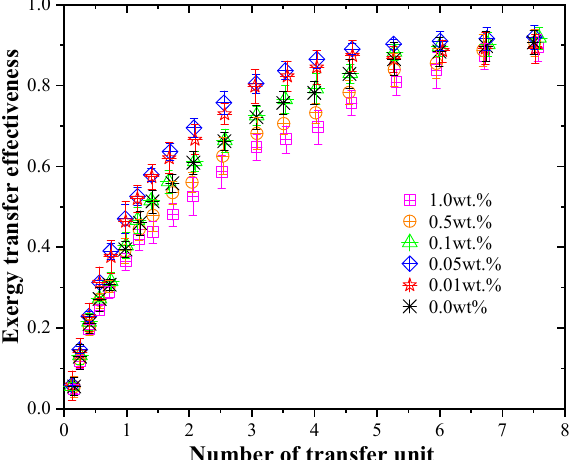
Figure 8. Effects of nanofluids mass fraction on exergy transfer effectiveness at different NTU.